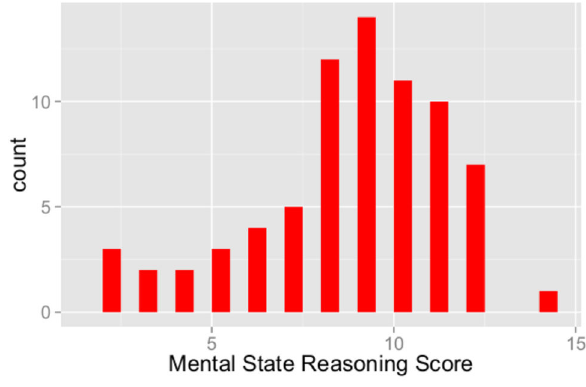
Figure 1. Distribution of the mental state reasoning score.